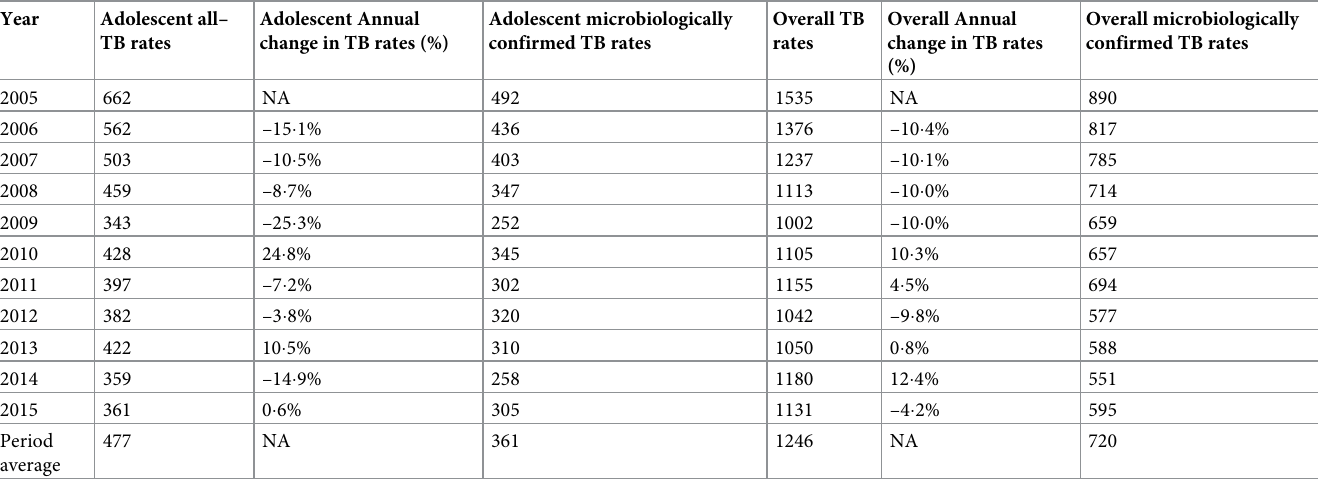
Table 2. TB rate by year, age and diagnostic